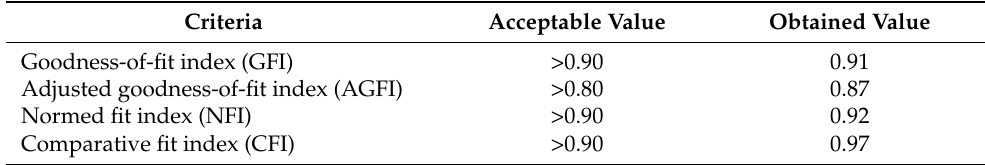
Table 4. E-service satisfaction model fit